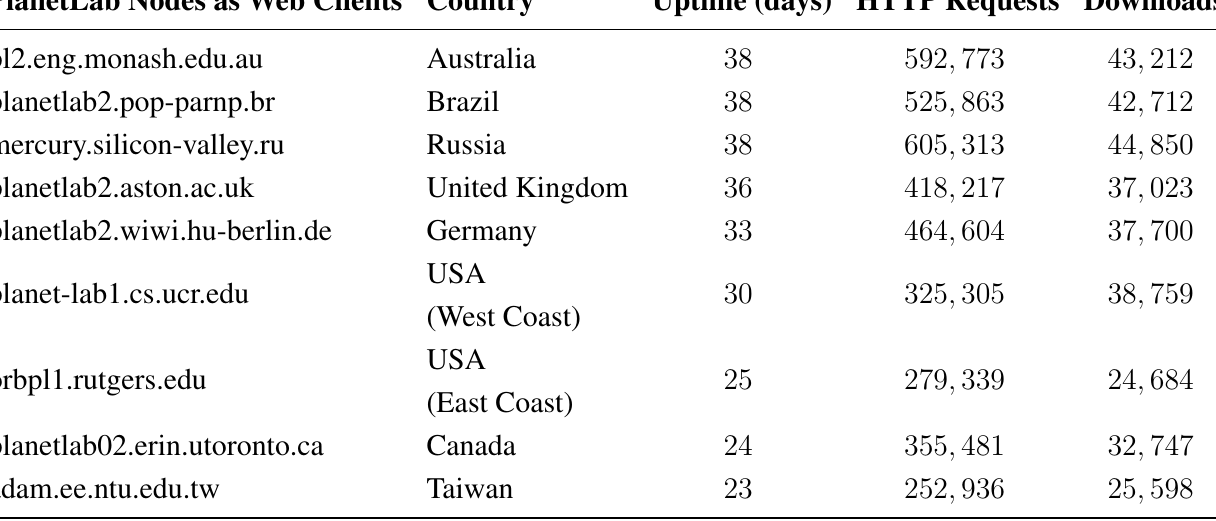
Table 3. Experimental